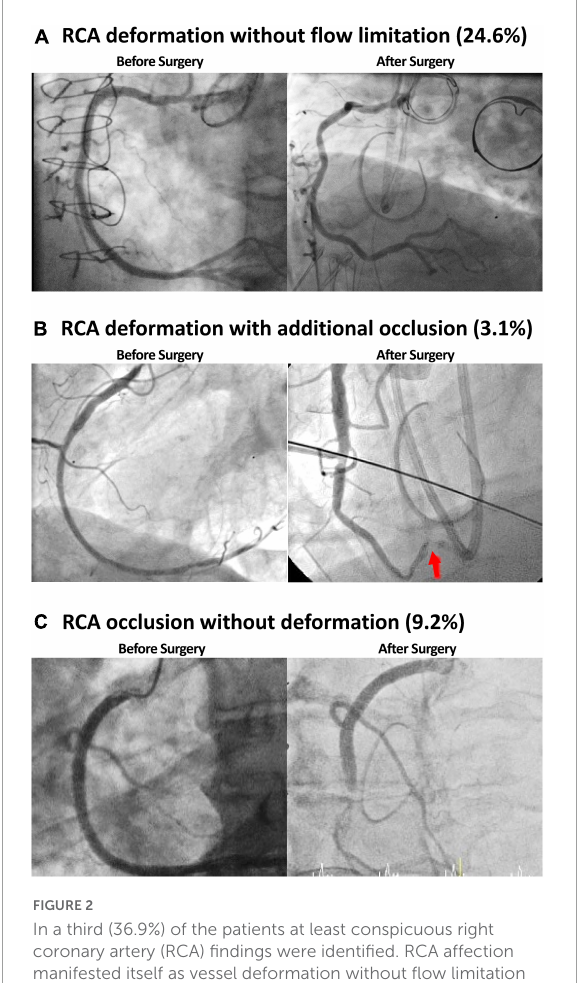
FIGURE2 In a third (36.9%) of the patients at least conspicuous right coronary artery (RCA) findings were identified. RCA affection manifested itself as vessel deformation without flow limitation (A) , occlusion with additional deformation (B), and occlusion without deformation (C)